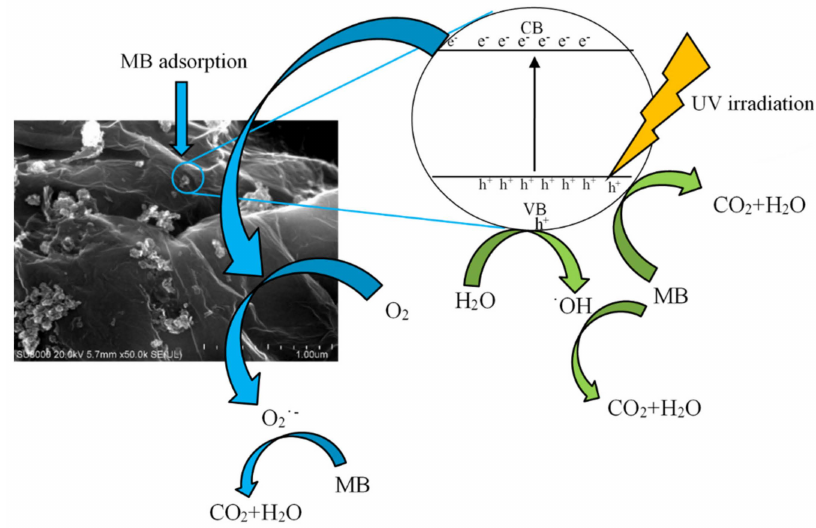
Figure 12. The reaction mechanism for photocatalytic degradation of MB with TiO 2 /rGO photocata- lyst under UV